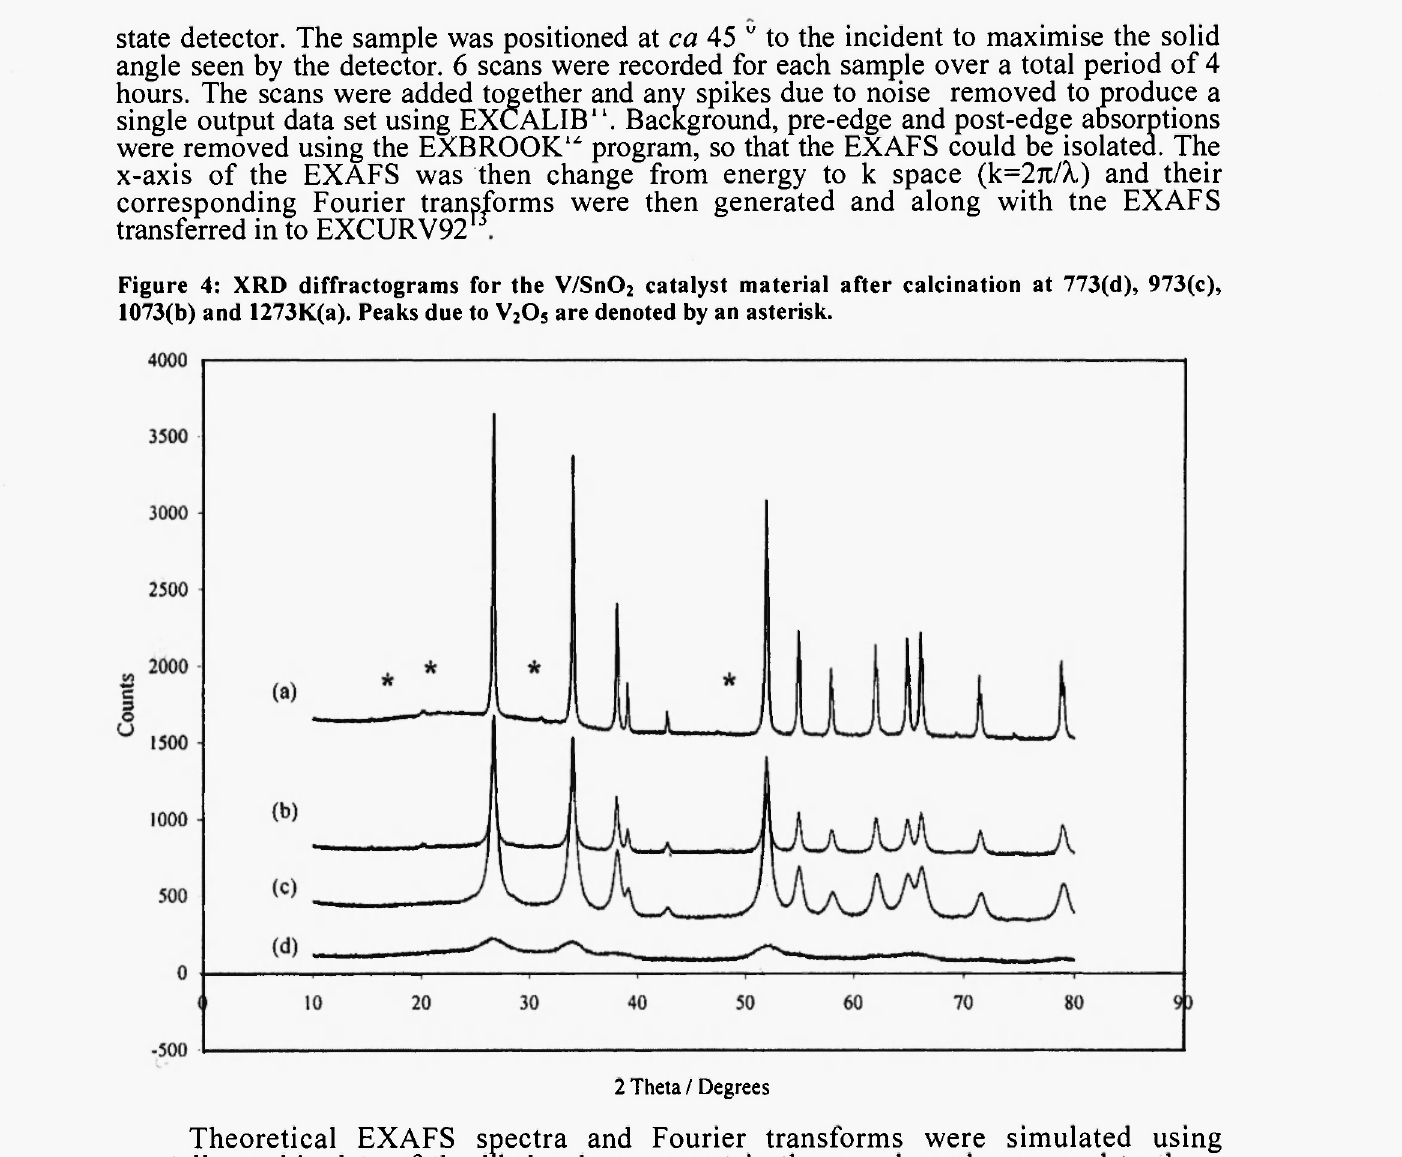
Figure 4: XRD diffractograms for the V/Sn0 2 catalyst material after calcination at 773(d), 973(c), 1073(b) and 1273K(a). Peaks due to V 2 O s are denoted by an